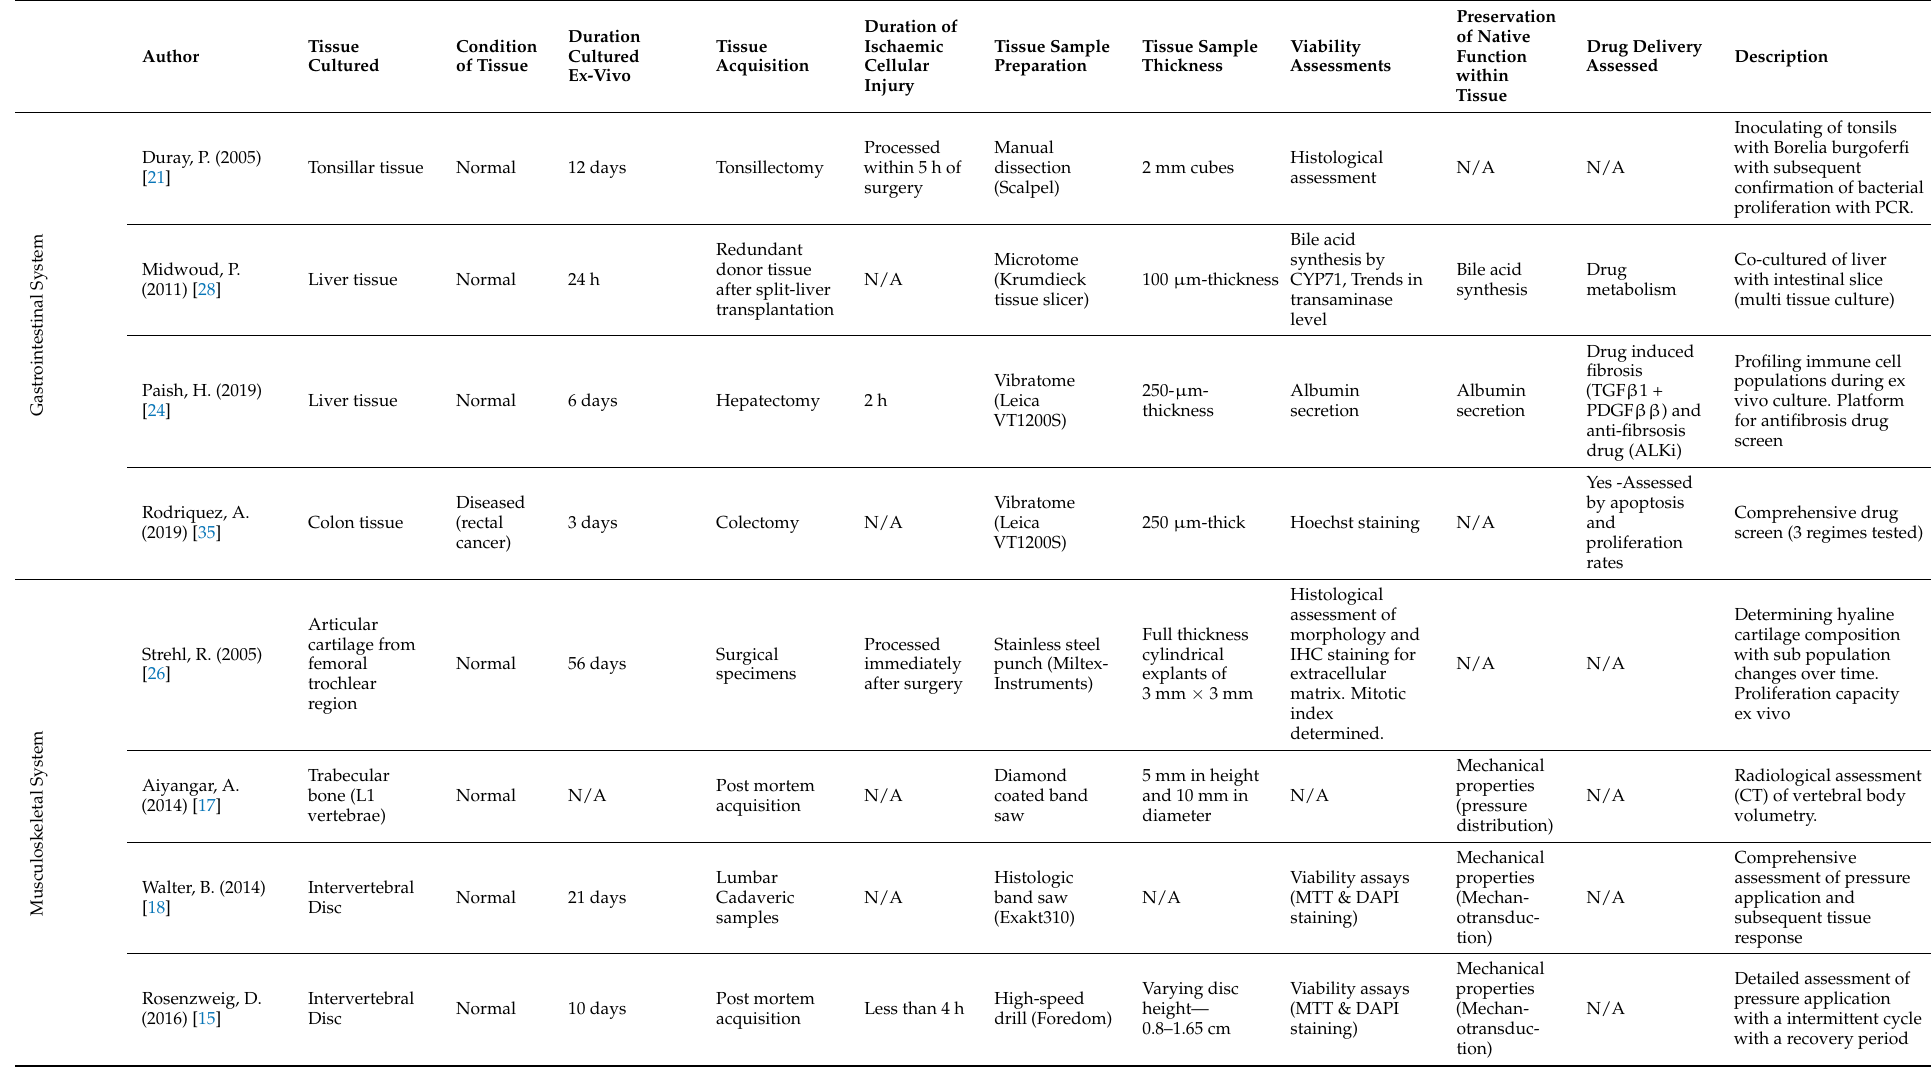
Table 4. Description of studies with successful culture of ex vivo human tissue utilising dynamic physiological